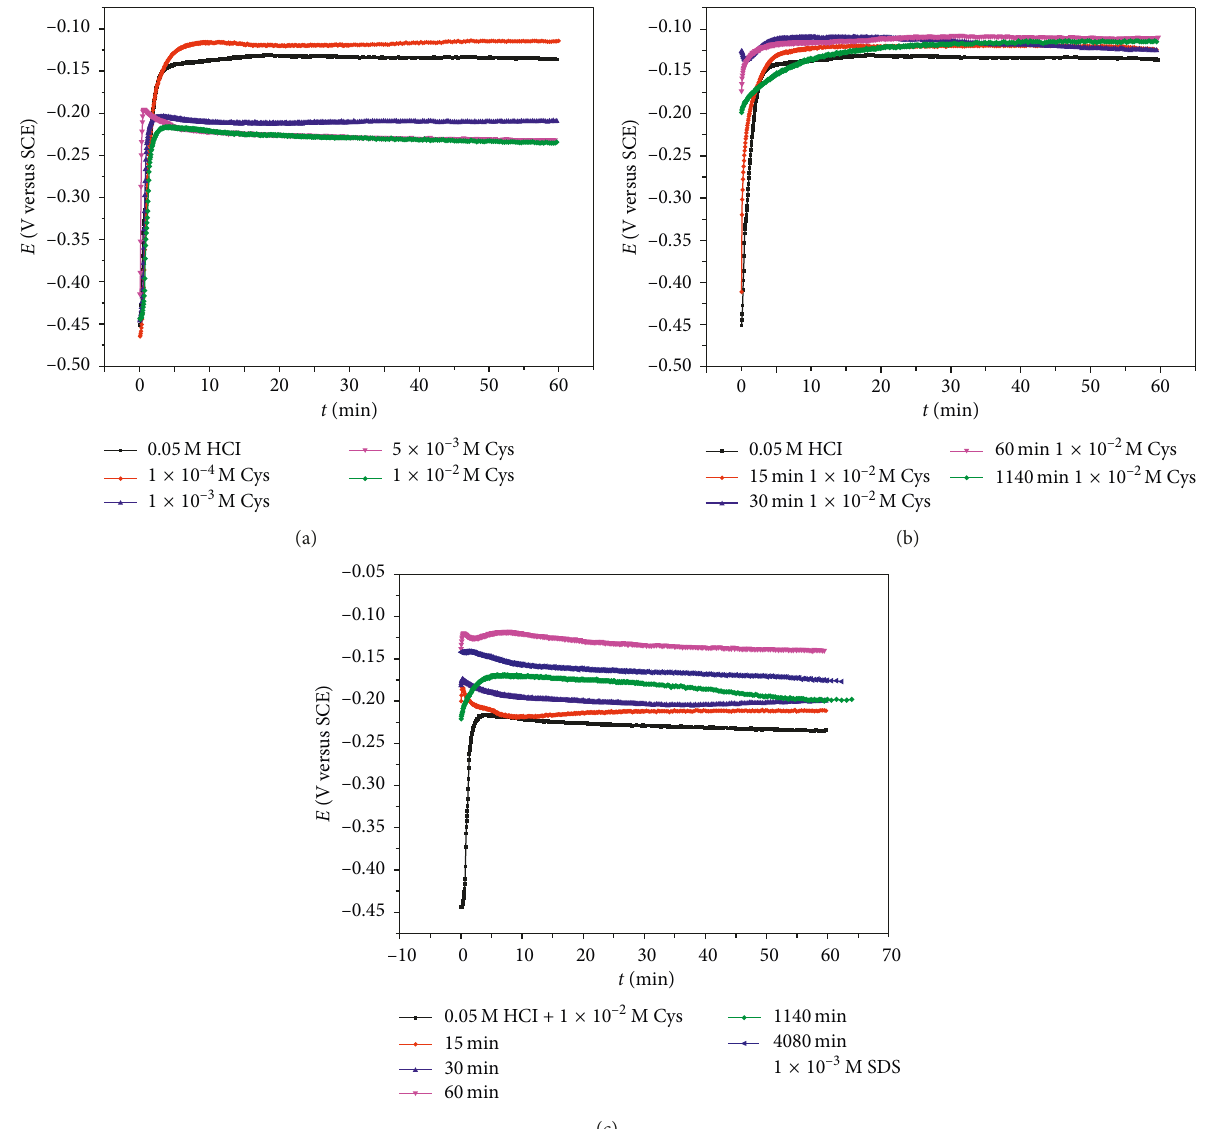
Figure 2: Open circuit potential of brass in 0.05M HCl solution (a) without and with the addition of different concentrations of cysteine (1 · 10 − 4 to 1 · 10 − 2 M), (b) after immersion in 1 · 10 − 2 M cysteine solution for various periods of time (15, 30, 60, and 1140min), and (c) OCP of brass in 0.05M HCl +1 · 10 − 2 M cysteine solution after immersion in 1 · 10 − 3 M SDS solution for various periods of time (15, 30, 60, 1200, and